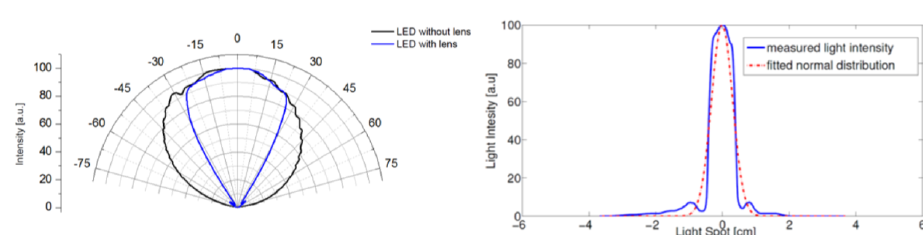
Figure 2. ( left ) Angular far-field from a single LED with and without lens at 125 mA bias, ( right ) LED with lens light intensity versus spot size with Gaussian fit.